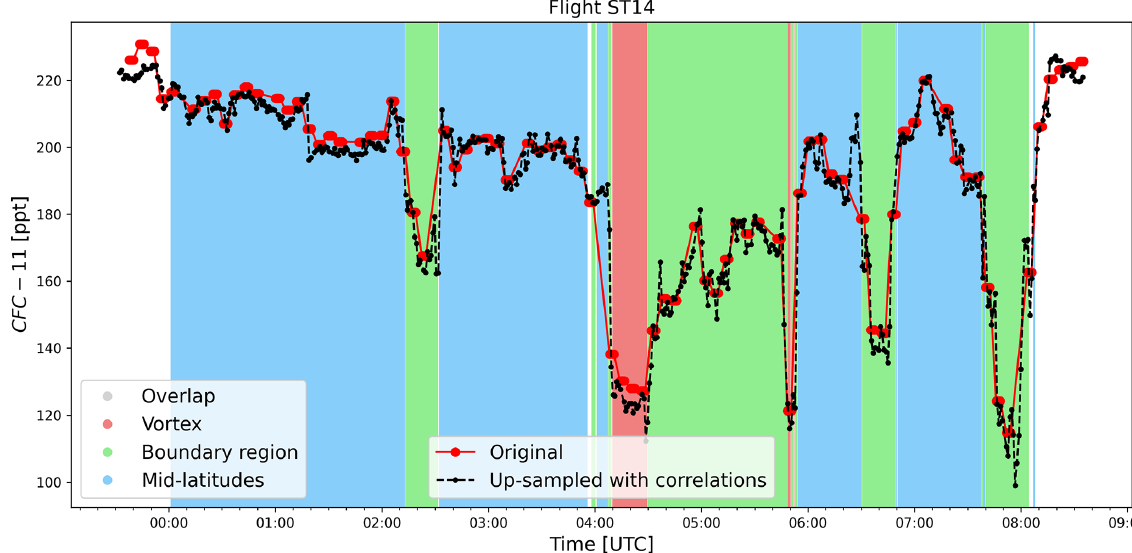
Figure 5. CFC-11 measured in the GhOST-MS during flight ST14 on 26 September 2019. Original data are shown in red, and measurements up-sampled using CFC-12 from the ECD channel are shown in black. Background colors indicate in which region the samples were taken using the air mass classification in (cid:50)